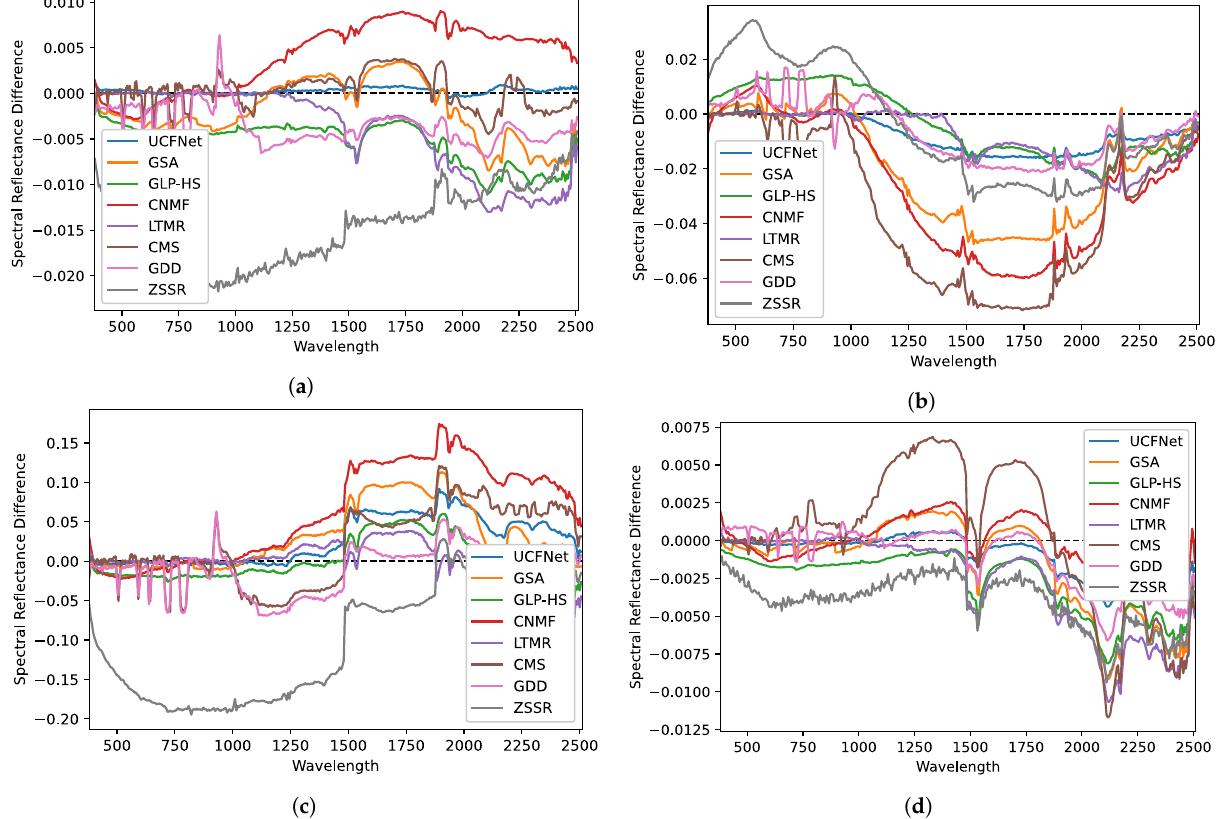
Figure 6. Spectral reflectance difference between of the reconstructed and the reference HSI. Dataset AVIRIS-NG-Cuprite with a scaling factor of 8. ( a ) Endmember 1. ( b ) Endmember 3. ( c ) Endmember 4. ( d ) Endmember